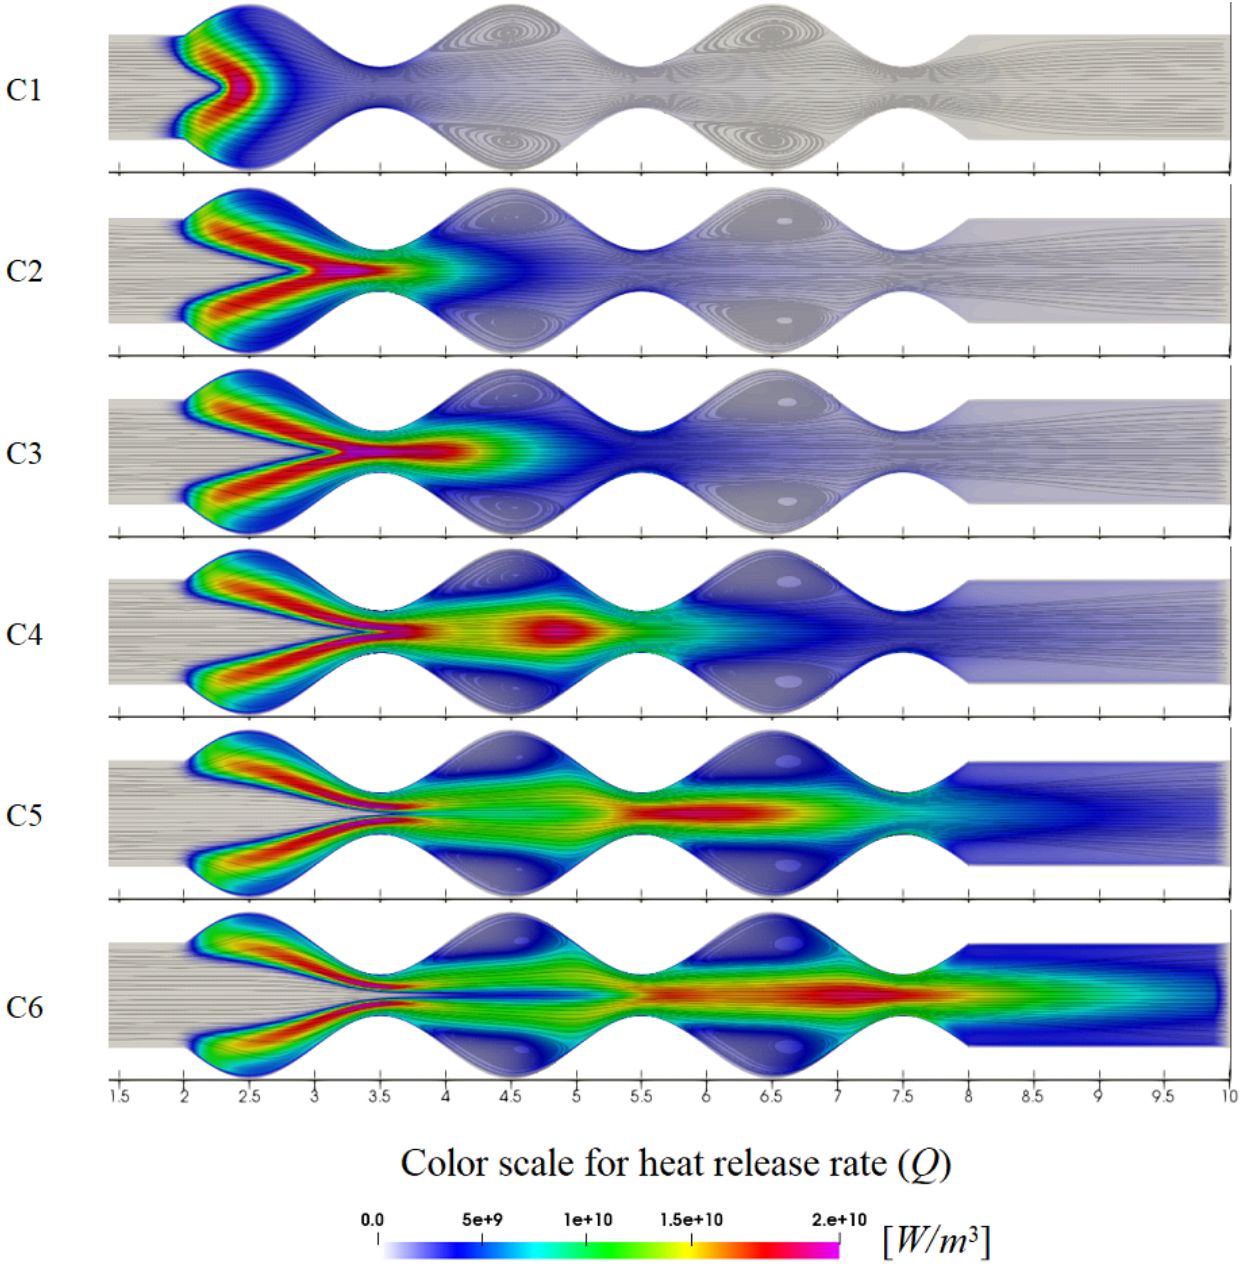
Figure 4. Contour maps for the streamlines superimposed on heat release rate distribution for different